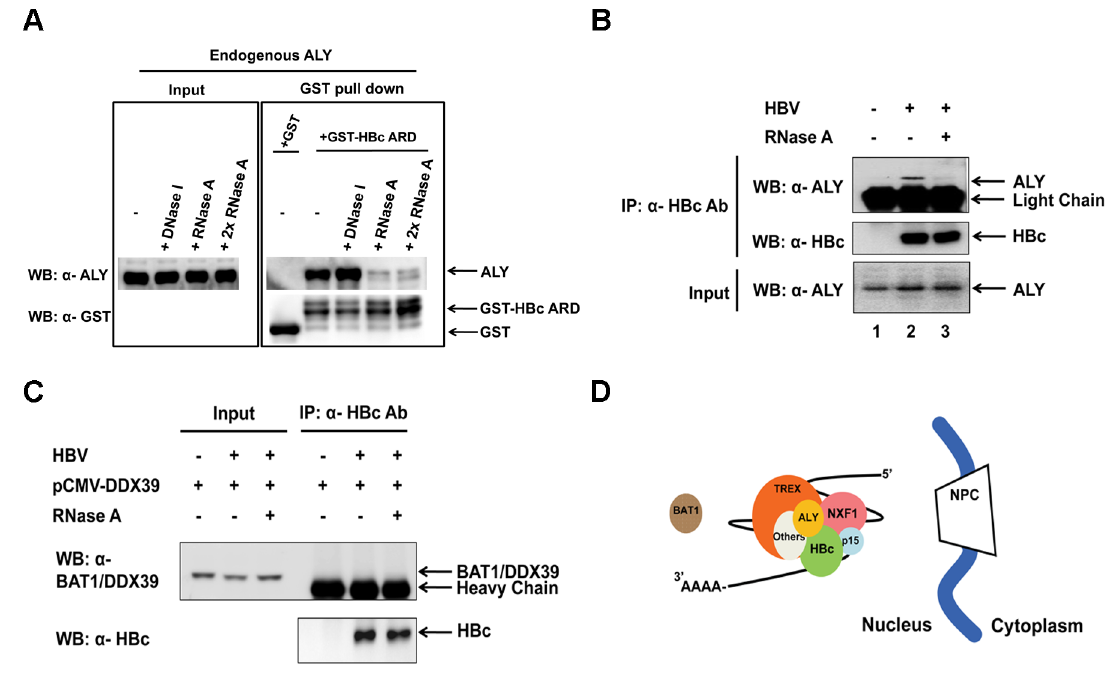
Figure 3. Association between HBc ARD and TREX complex. A) The association between GST-HBc ARD and a TREX component ALY was ribonuclease (RNase)-sensitive and DNase-resistant in a GST pull down assay. This assay was performed by using E. coli - expressed GST or GST-HBc ARD protein and untransfected HuH-7 cell lysates (Materials and Methods). B) Full-length HBc 183 protein in HuH-7 cells transiently transfected with an HBV genome can also co-immunoprecipitate the endogenous ALY in an RNase-sensitive manner. C) HuH-7 cells were co-transfected with an HBV genome and a pCMV-DDX39 expression vector. Full-length HBc 183 protein cannot associate with another TREX component BAT1/DDX39 in the co-IP assay. D) A cartoon summarizes the putative associations among HBc, RNA, ALY, TREX components, and others (other known or unknown cellular factors). Such associations are postulated to be involved in nuclear RNA processing and export. NPC: nuclear pore complex.